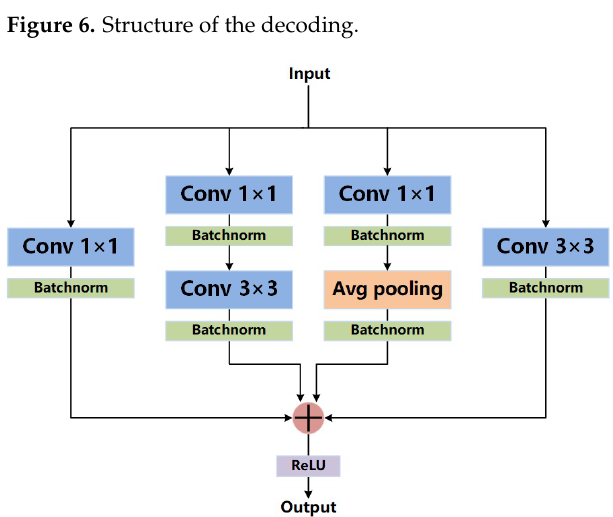
Figure 7. Structure of the diverse branch